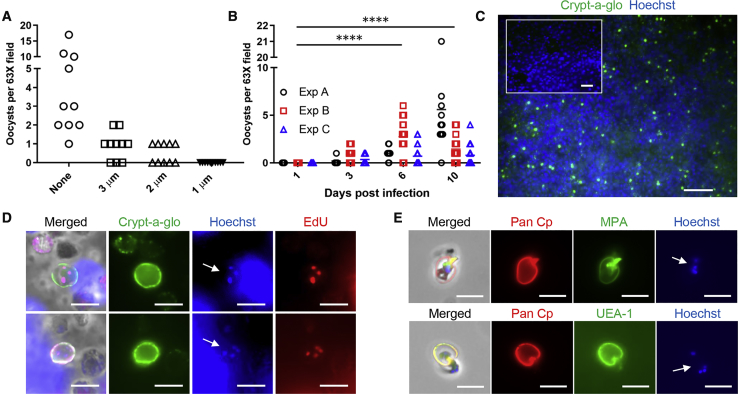
In vitro production of oocysts in ALI culture(A) Effect of filtration on removal of residual C. parvum oocysts. Oocysts were excysted, filtered using the indicated pore sizes, added to PLL-coated coverslips, and stained with Crypt-a-glo directly conjugated to FITC. The number of residual oocysts found in filtered samples were counted from replicate 63× fields from a representative experiment.(B) Detection of C. parvum oocysts in ALI cultures. Transwells were infected on day 3 post top medium removal with 1 μm-filtered sporozoites. On specified days post infection, transwells were fixed and stained with Crypt-a-glo directly conjugated to FITC and Pan Cp, detected with goat anti-rabbit IgG Alexa Fluor 568. Oocyst numbers per 63× field were counted for three independent experiments (Exp A, Exp B, Exp C). The combined mean of each time point was compared to the combined mean of day 1 using a two-way ANOVA corrected for multiple comparisons using the Dunnett method, ∗∗∗∗ p < 0.0001.(C) Low magnification (20×) image of oocyst development in ALI transwells infected with 1 μm-filtered sporozoites 10 days or 1 day post infection (inset). Transwells were stained with Crypt-a-glo directly conjugated to FITC to detect oocysts. DNA stained with Hoechst. Scale bars, 50 μm.(D) Labeling of newly formed oocysts with EdU. ALI transwells were infected on day 3 post top medium removal with 1 μm-filtered sporozoites. On day 2 post infection, 10 μM EdU was added to the bottom chamber medium and incubated overnight. Transwells were fixed and EdU was labeled using the Click-iT EdU Alexa Fluor 488. C. parvum was labeled with Crypt-a-glo directly conjugated to FITC, DNA stained with Hoechst (white arrows denote nuclei). Scale bars, 5 μm.(E) Lectin labeling of oocysts. Transwells were infected with 1 μm-filtered sporozoites and bleached on day 3 post infection, adhered to PLL-coated coverslips, and stained with Pan Cp followed by goat anti-rabbit Alexa Fluor 568, Hoechst, and either lectins MPA or UEA-1 directly conjugated to FITC. DNA stained with Hoechst (white arrows denote nuclei). Scale bars = 5 μm.